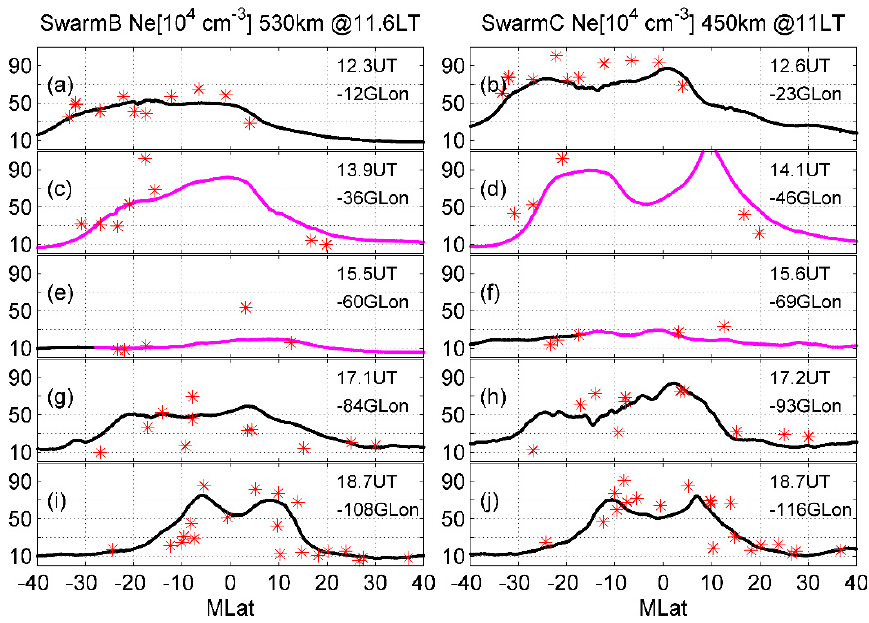
Figure 2. MLat variations of noon Ne from Swarm B ( left ) and C ( right ) on 15 January 2022. The magenta lines are referred to as the plasma during the arrival of the Lamb wave. The density at the remaining times is indicated by black lines. The red star is the COSMIC-observed Ne at corresponding altitudes, longitudes, and latitudes. The UT and GLon of each Swarm orbit are given in the right hand of each subfigure. The density is given in 10 4 cm − 3 .